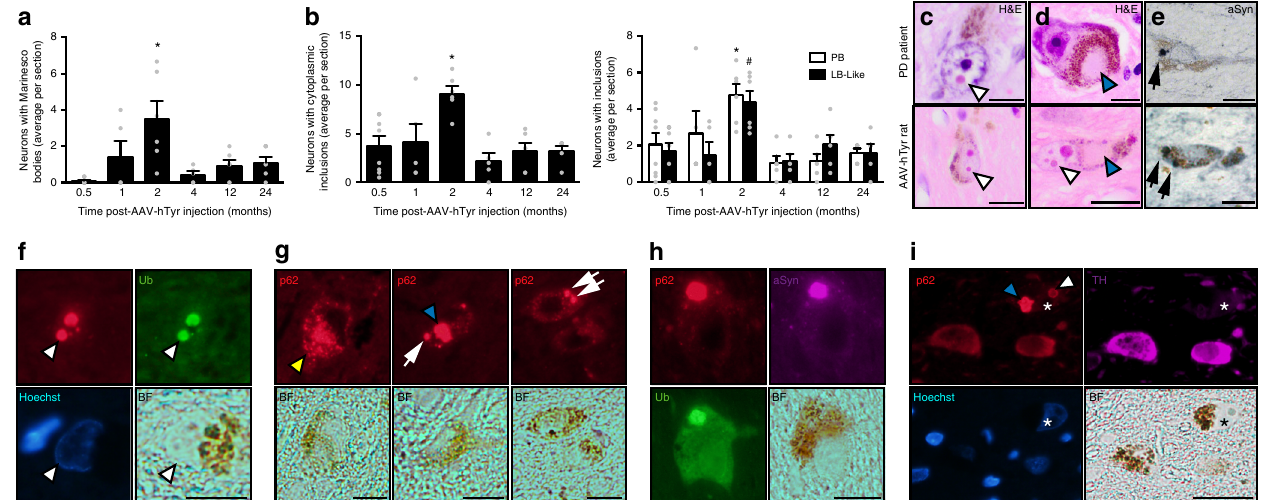
Fig. 6 PD-type inclusion formation in AAV-hTyr-injected rats. a Quanti fi cation of NM-laden neurons with p62-positive intranuclear Marinesco bodies (MB) in ipsilateral SNpc from AAV-hTyr-injected rats. * p < 0.05, compared to 0.5 m (ANOVA on ranks; Dunn ’ s post-hoc test). b Quanti fi cation of NM-laden neurons with p62-positive total intracytoplasmic inclusion bodies (left) and pale bodies (PB) and/or Lewy body (LB)-like p62-positive inclusions (right) in ipsilateral SNpc from AAV-hTyr-injected rats. Left, * p < 0.05, compared to 0.5, 1, 4, 12, and 24 m (one-way ANOVA; Student – Newman – Keuls post-hoc test). Right, * p < 0.05, compared to PB at 0.5, 4, 12, and 24 m; # p < 0.05, compared to LB-like inclusions at 0.5, 1, 4, and 24 m (two-way ANOVA; Holm- Sidak post-hoc test). c – e Midbrain sections from PD post-mortem brains (top) and AAV-hTyr-injected rats (bottom) exhibiting MB ( c , white arrowheads), PB ( d , blue arrowheads) and LB-type aSyn-positive inclusions ( e , arrows). In c , d , Hematoxylin-eosin (H&E) staining. In e , aSyn immunostaining (in blue). Scale bars, 12.5 μ m. f Ipsilateral SNpc sections from AAV-hTyr-injected rats exhibiting NM-laden neurons with MB (white arrowhead) detected by immuno fl uorescence with p62 (red) and ubiquitin (Ub, green). Nuclei are stained with Hoechst (blue). Scale bar, 12.5 μ m. g Ipsilateral SNpc sections from